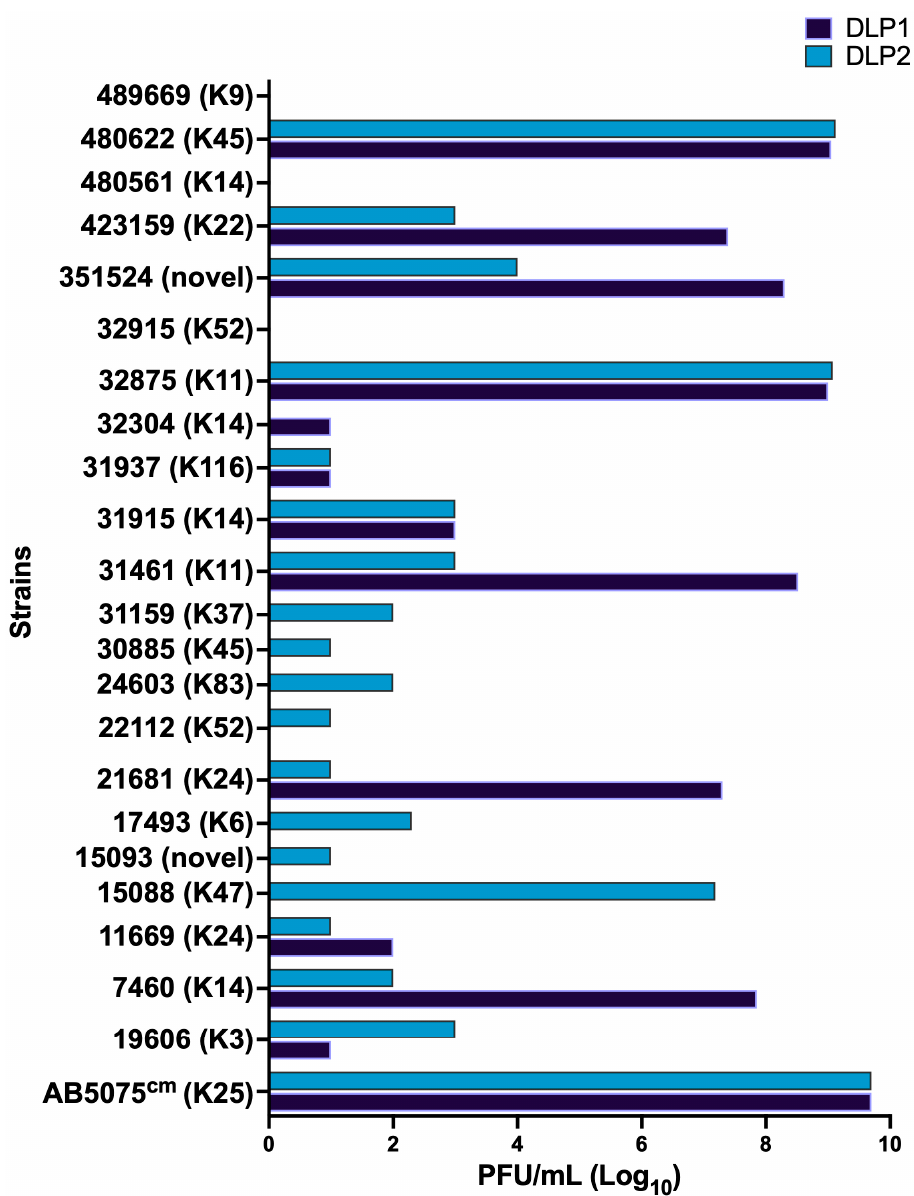
Figure 2. Efficiency of plating for DLP1 and DLP2 susceptible strains with K-type listed in brackets. A dilution series of standardized DLP1 and DLP2 stock (2.5 × 10 9 PFU/mL) was spot-plated on each host and scored for level of infectivity. An EOP of zero indicates decreased turbidity on the phage spot-plates at the highest concentration, but no plaquing is observed. Data represent the mean of a technical triplicate.